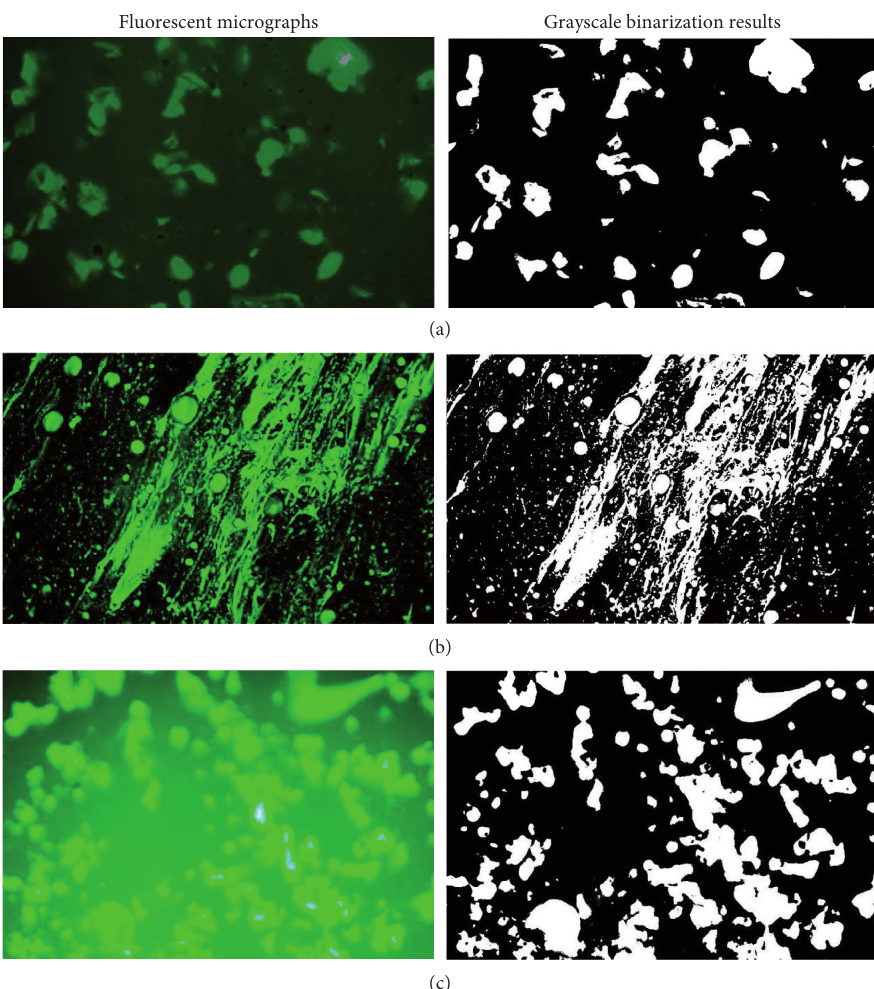
Figure 7: Fluorescence micrographs of different asphalts. (a) AR-HVA, (b) AR-HVA + M 1, (c) AR-HVA